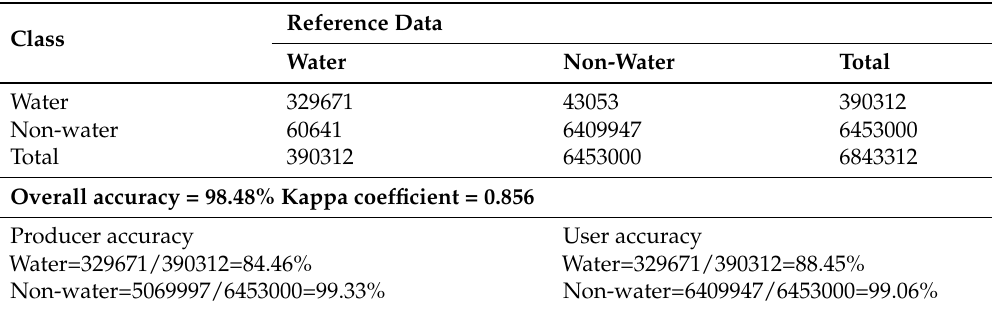
Table 6. Error matrix of the proposed method classified image (Dataset